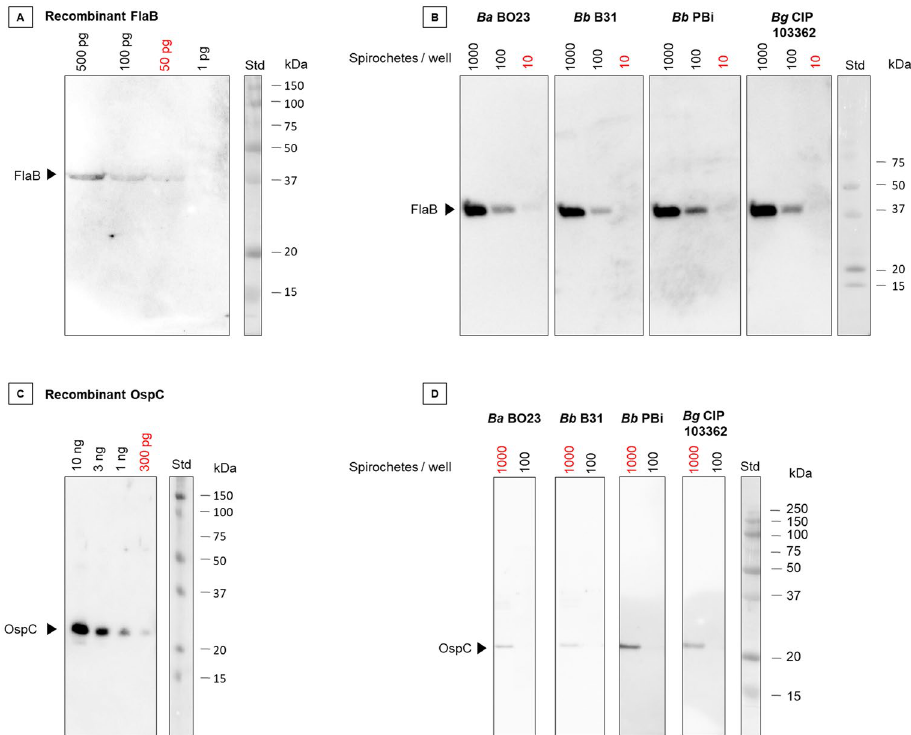
Figure 1. Western blot detection of FlaB and OspC using the best selected mAb. ( A ) Range of recombinant FlaB from 500 to 1 pg per well detected with FlaB-15 mAb and ( C ) recombinant OspC from 10 ng to 40 pg per well detected with C10-11 mAb. ( B , D ) Various Borrelia strains loaded at 10 3 and 10 2 bacteria per lane and detected with FlaB-15 ( B ) and C10-11 mAbs ( D ). Std: Molecular weight markers and protein sizes (kDa) are indicated on the right side of the gels. Uncropped original images are reported in Fig. S2.